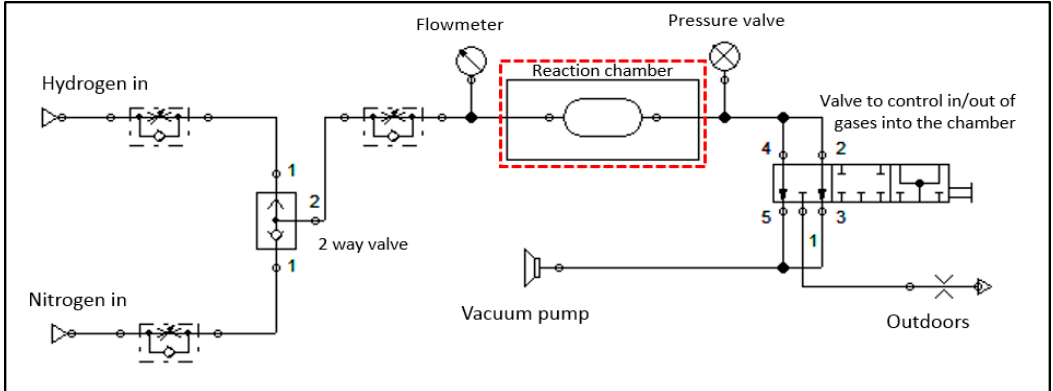
Figure 1. Schematic diagram of the hot filament chemical vapor deposition (HFCVD) homemade system used to grown films in this work.